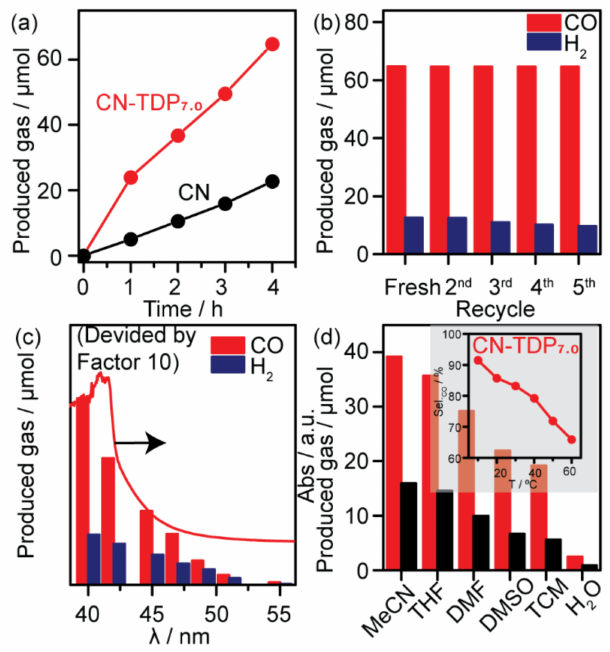
Figure 5. ( a ) Time function CO 2 reduction reaction. ( b ) Stability experiments of CN-TDP 7.0 photocata- lyst. ( c ) Different wavelength experiments. ( d ) Different solvent experiments by using as-synthesized samples under visible